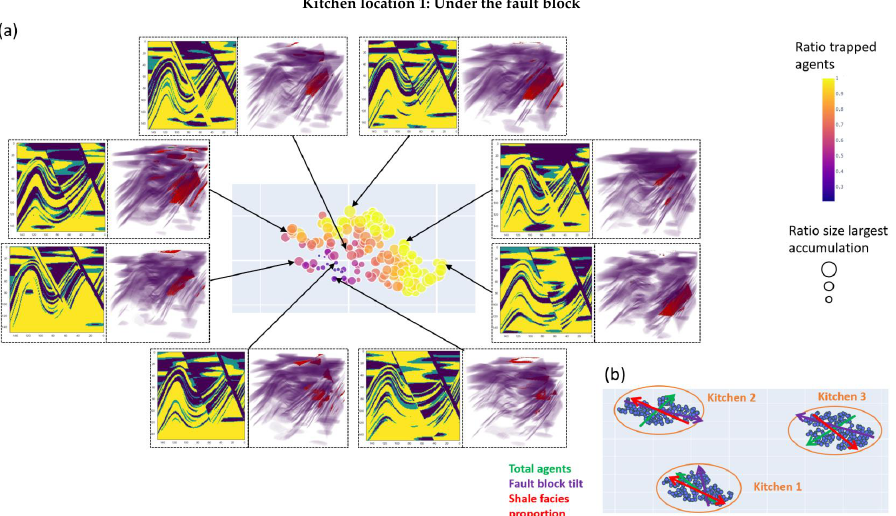
Figure A2. ( a ) t-SNE analysis of kitchen scenario 1 showing the most impactful geological uncertainties and their correlation with simulation evaluation metrics. Each point represents an individual model from the Monte Carlo simulation. The points are colour coded with the evaluation metric ratio of trapped agents and sized by the size of the most significant accumulation. One observation is that all the accumulations remain in the fault block area. Exemplary 2D slices of the environment and 3D plots showing the accumulation positions at the end of the simulation (red) and the barriers (purple) are also shown ( b ) Display of the trends of the original geological parameters with colour coded arrows.